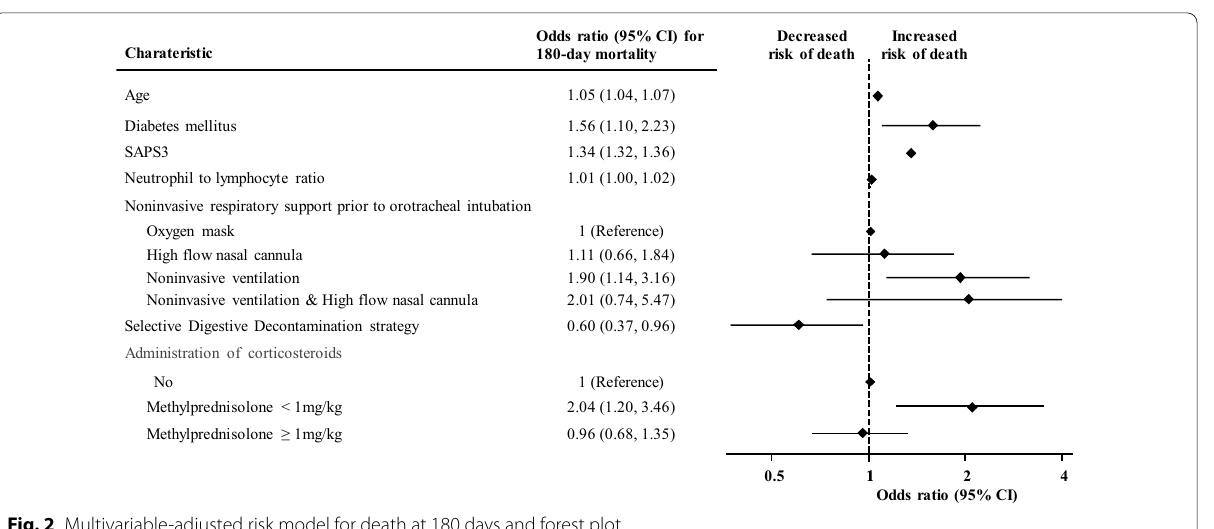
Fig. 2 Multivariable‑adjusted risk model for death at 180 days and forest